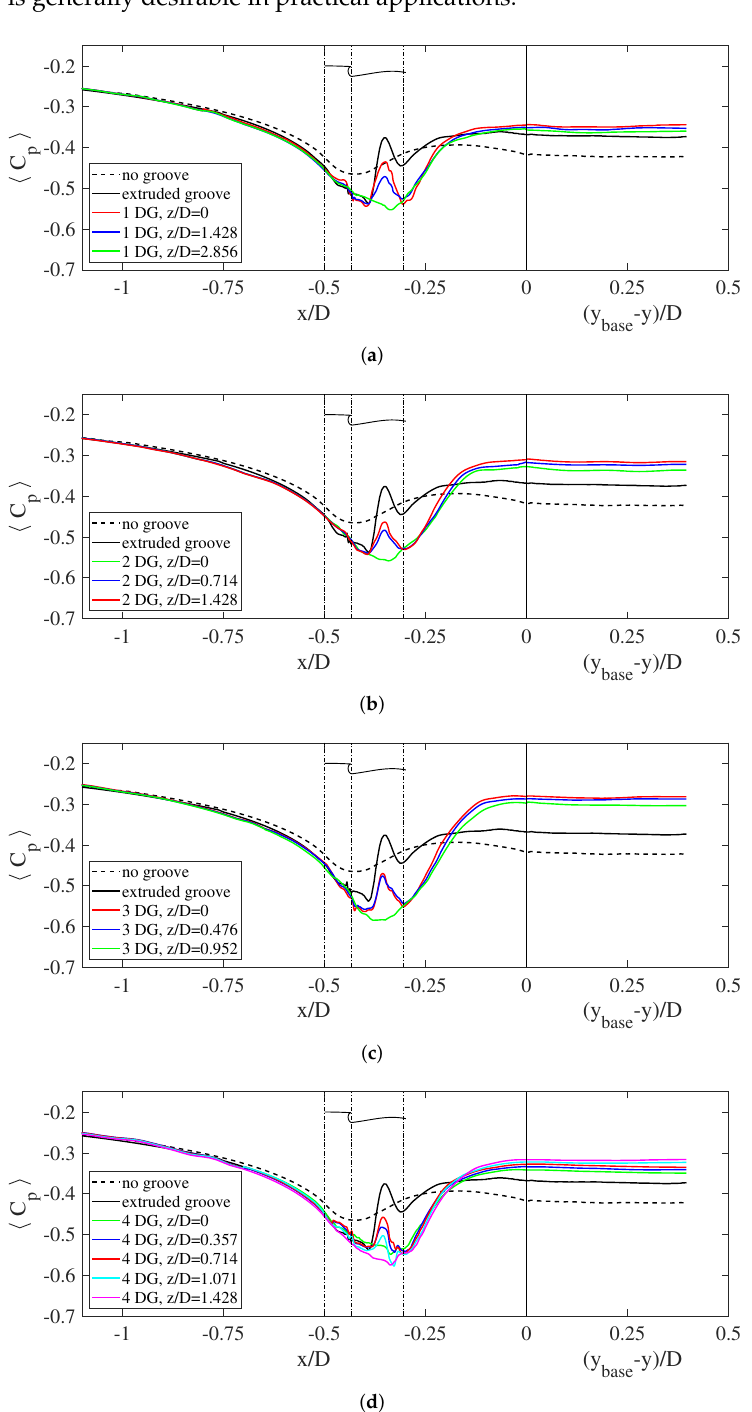
Figure 9. Mean pressure coefficient distributions for the spanwise-discontinuous grooves with: ( a ) N = 1, ( b ) N = 2, ( c ) N = 3, and ( d ) N = 4. The results for the boat-tail without the groove and for the extruded groove are from